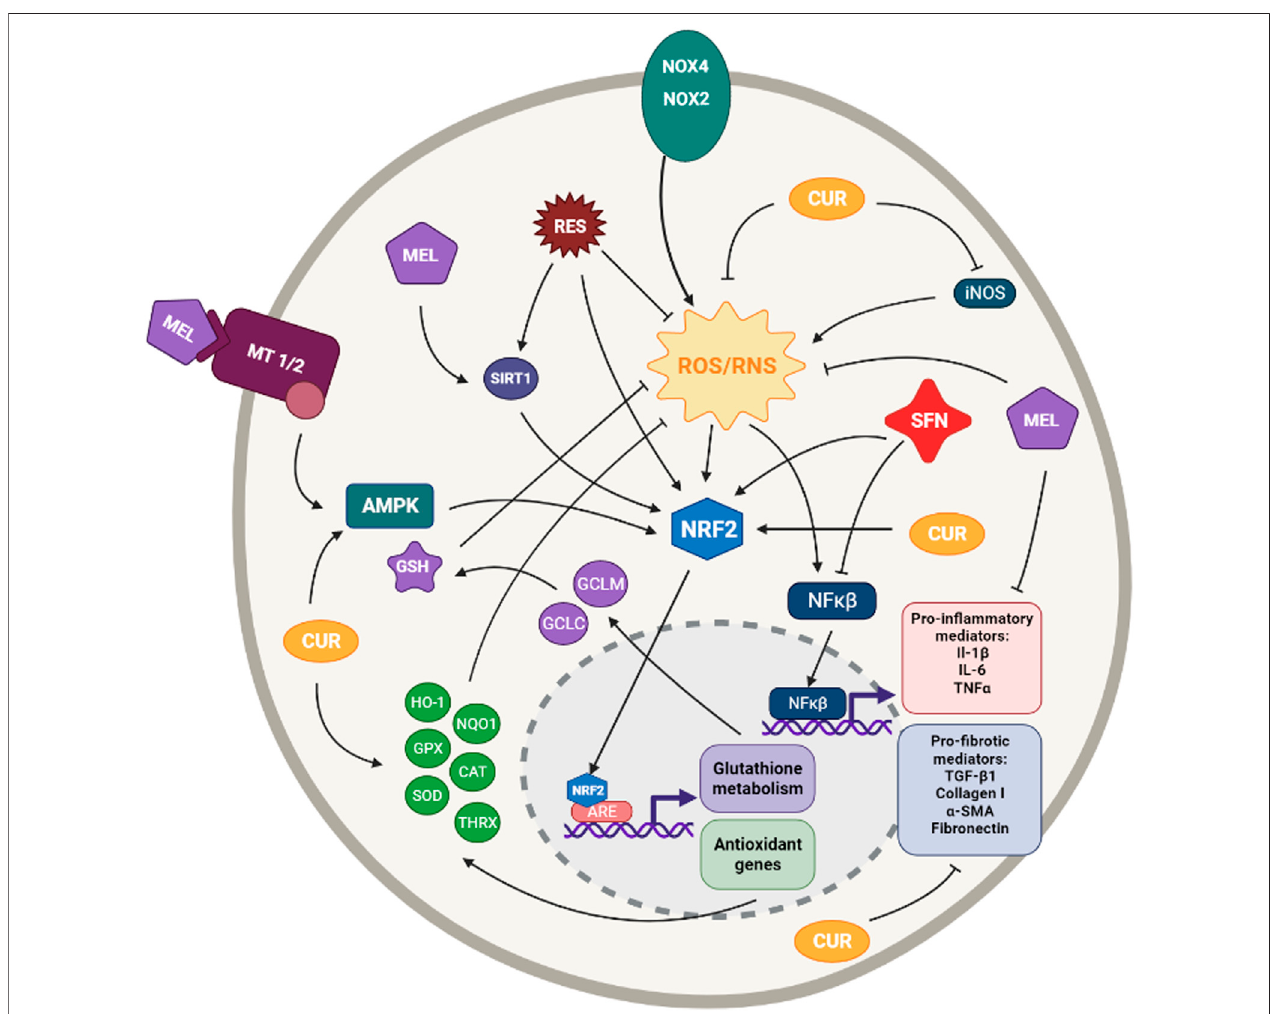
FIGURE 4 | Simpli fi ed diagram of the principal molecular mechanisms of the antioxidant enhancers Resveratrol (RES), Sulforaphane (SFN), Melatonin (MEL) and Curcumin (CUR). α SMA: alpha smooth muscle actin; AMPK: AMP-activated protein kinase; ARE: antioxidant responsive element CAT: catalase; CYS: cysteine; GCLC: glutamate cysteine ligase catalytic subunit; GCLM: glutamate cysteine ligase modi fi er subunit; GLUT: glutamate; GPX: glutathione peroxidase; GSH: glutathione; HO-1: heme oxygenase1; IL-1 β :interleuquina 1beta; IL-6: interleuquina 6;iNOS: inducible nitrogen oxide synthase; NF κβ :nuclearfactor kappa beta;NOX1,2,4: NADPH oxidases; NQO1: NAD(P)H:quinone oxidoreductase 1; NRF2: nuclear factor erythroid 2-related factor 2; ROS/RNS: reactive oxygen species/reactive nitrogen species; TGF- β 1: transforming growth factor beta 1; TNF α : tumoral necrosis factor alpha; SIRT: sirtuine 1; SOD: supeoxide dismutase Created with Biorender.com.